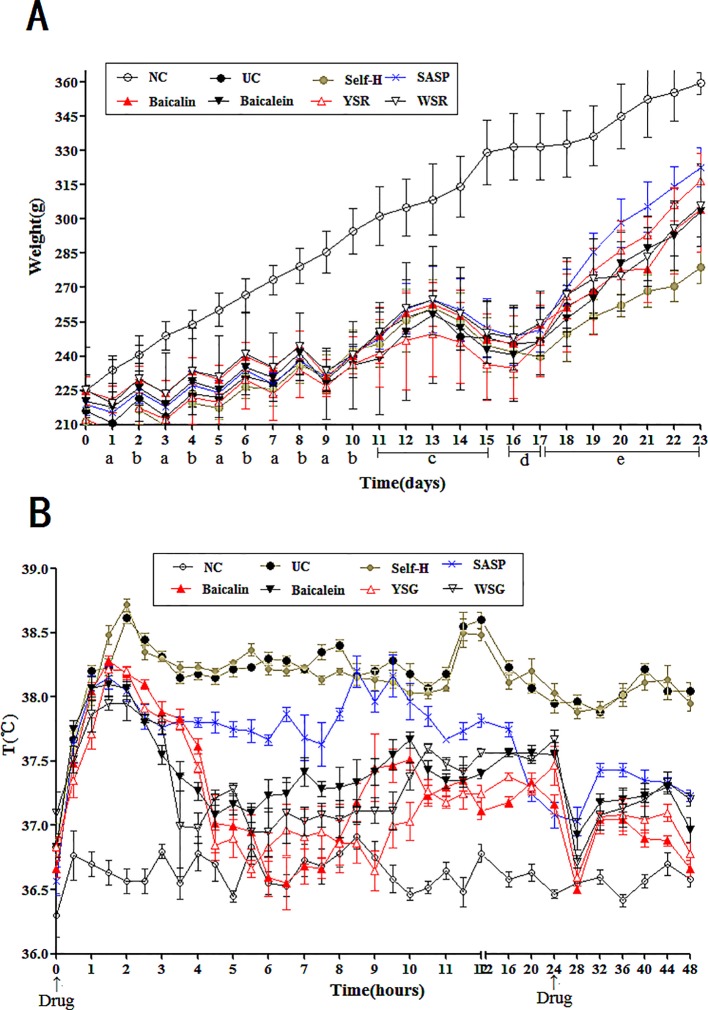
Changes of body temperature and body weight in rats. (A) Changes of body weight in rats; a, fast; b, diet with lard; c, drinking Erguotou with HTHE; d, E coli. infection; e, treatment. (B), Changes of 48-h body temperature in rats. The data are presented as the mean ± S.D. (n = 7).